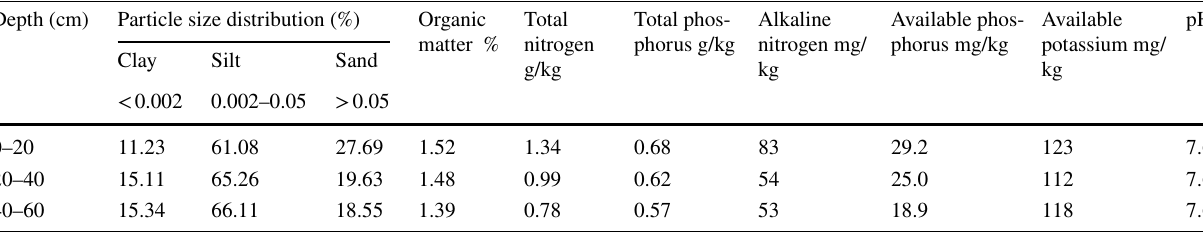
Table 1 Chemical properties of the soil Depth (cm) Particle size distribution